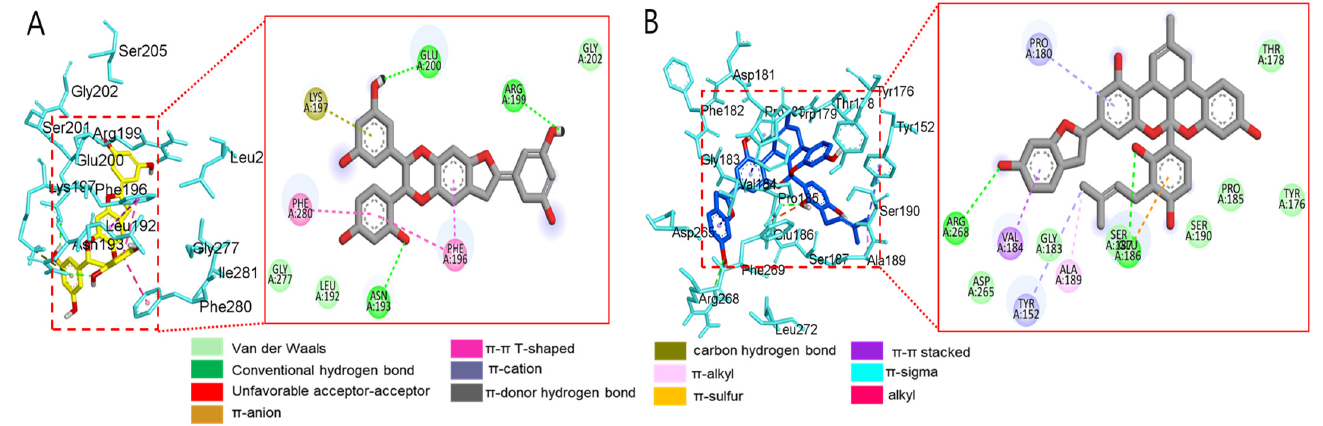
Figure 8. Molecular docking simulation models for PTP1B inhibition at the allosteric site by austrafuran C ( A ) and mulberrofuran F ( B ). 3D (left) and 2D (right) docking simulations were shown at each compound. Interaction was di ff erentiated by various color (left bo tt om). Table 6. Binding site residues and docking scores of compounds in the PTP1B using the AutoDock Vina 4.2 program.